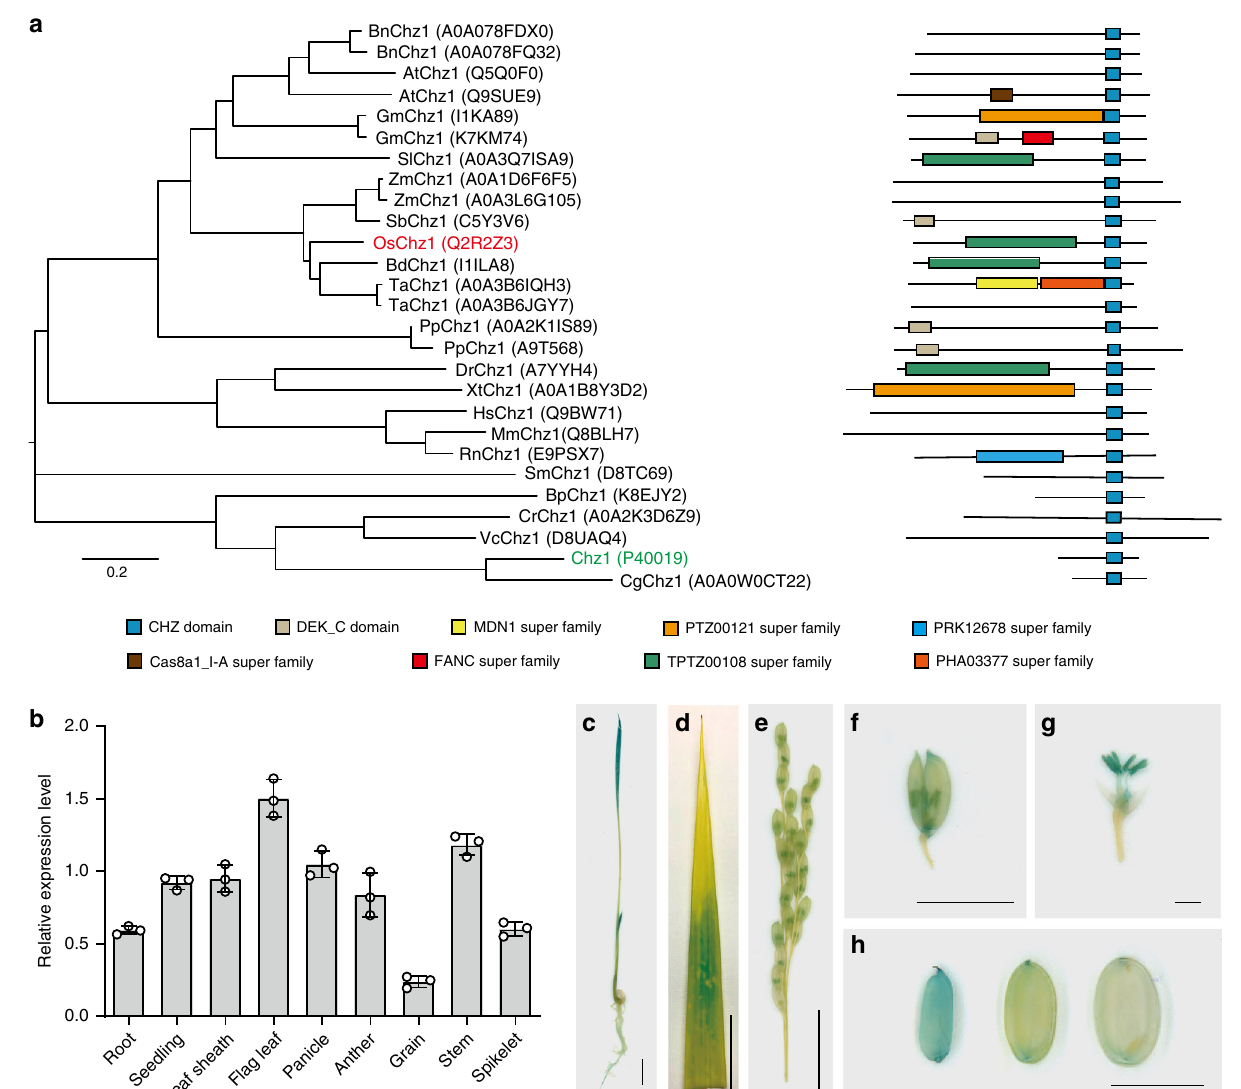
Fig. 1 Identi fi cation and expression analysis of OsChz1 . a Phylogenetic tree (left) and protein domain organization (right) analyses of CHZ-domain- containing proteins in higher eukaryotes. The founding member from yeast (yChz1) was highlighted in green; and the Chz1 homolog identi fi ed in rice, OsChz1, was highlighted in red. Neighbor-Joining phylogeny based on full-length amino acid sequence alignment was calculated using MEGA v10.1.8 and illustrated using FigTree v1.4.3. The diverse protein domains are displayed in different colored boxes as indicated. Bn, Brassica napus ; At, Arabidopsis thaliana ; Sl, Solanum lycopersicum ; Gm, Glycine max ; Ta, Triticum aestivum ; Bd, Brachypodium distachyon ; Os, Oryza sativa ; Sb, Sorghum bicolor ; Zm, Zea mays ; Pp, Physcomitrella patens ; Xt, Xenopus tropicalis ; Dr, Danio rerio ; Hs, Homo sapien s; Mm, Mus musculus ; Rn, Rattus norvegicus ; Bp, Bathycoccus prasinos ; Sm, Selaginella moellendorf fi i ; Cr, Chlamydomonas reinhardtii ; Vc, Volvox carteri ; Cg, Candida glabrata . b Quantitative RT-PCR analysis of OsChz1 expression. Relative expression levels are shown for root (10-day-old), seedling (10-day-old), leaf sheath, fl ag leaf, panicle, anther, grain (3 days after anthesis), stem, and spikelet. The rice Ubiquitin5 gene was used as an internal control. Values are means ± standard deviation from n = 3 independent biological replicates. c – h Histochemical detection of pOsChz1:GUS expression in transgenic rice plants. GUS activity (staining in blue) was observed in seedling ( c ), fl ag leaf ( d ), panicle ( e ), spikelet ( f ), anther ( g ), and grains ( h ). Scale bars, 1 cm in c – e , 5 mm in f , h , 1 mm in g . Source data underlying b are provided as a Source Data fi